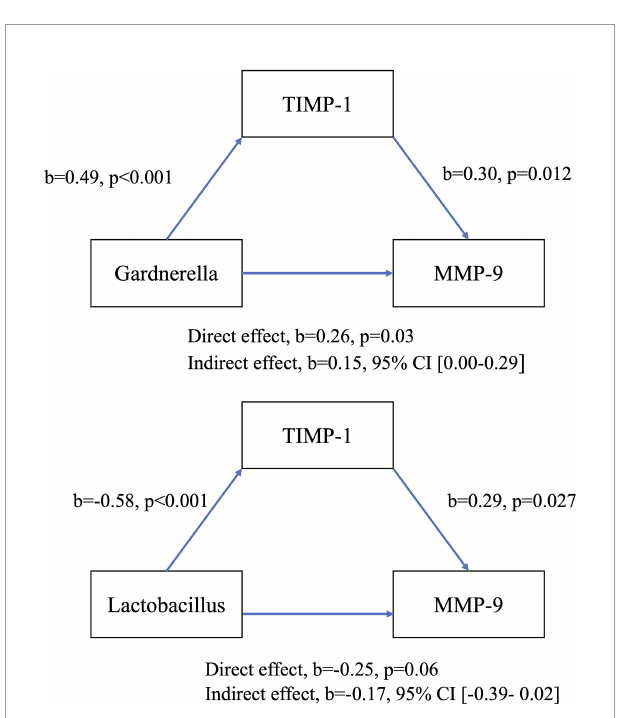
FIGURE 7 | Model of direct and indirect relationship between MMP-9, key bacterial genera and